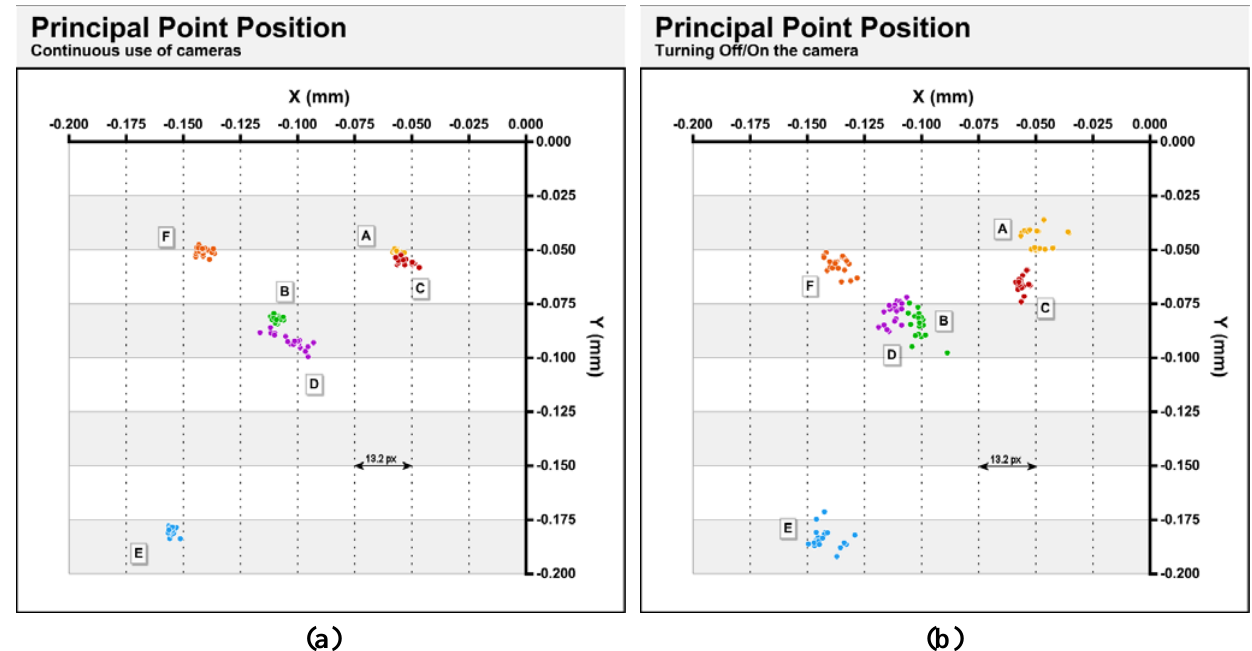
Figure 5. Principal point positions in the 372 calibrations done continuously (a), using power cycling (b) and after the full extension/retraction of the zoom